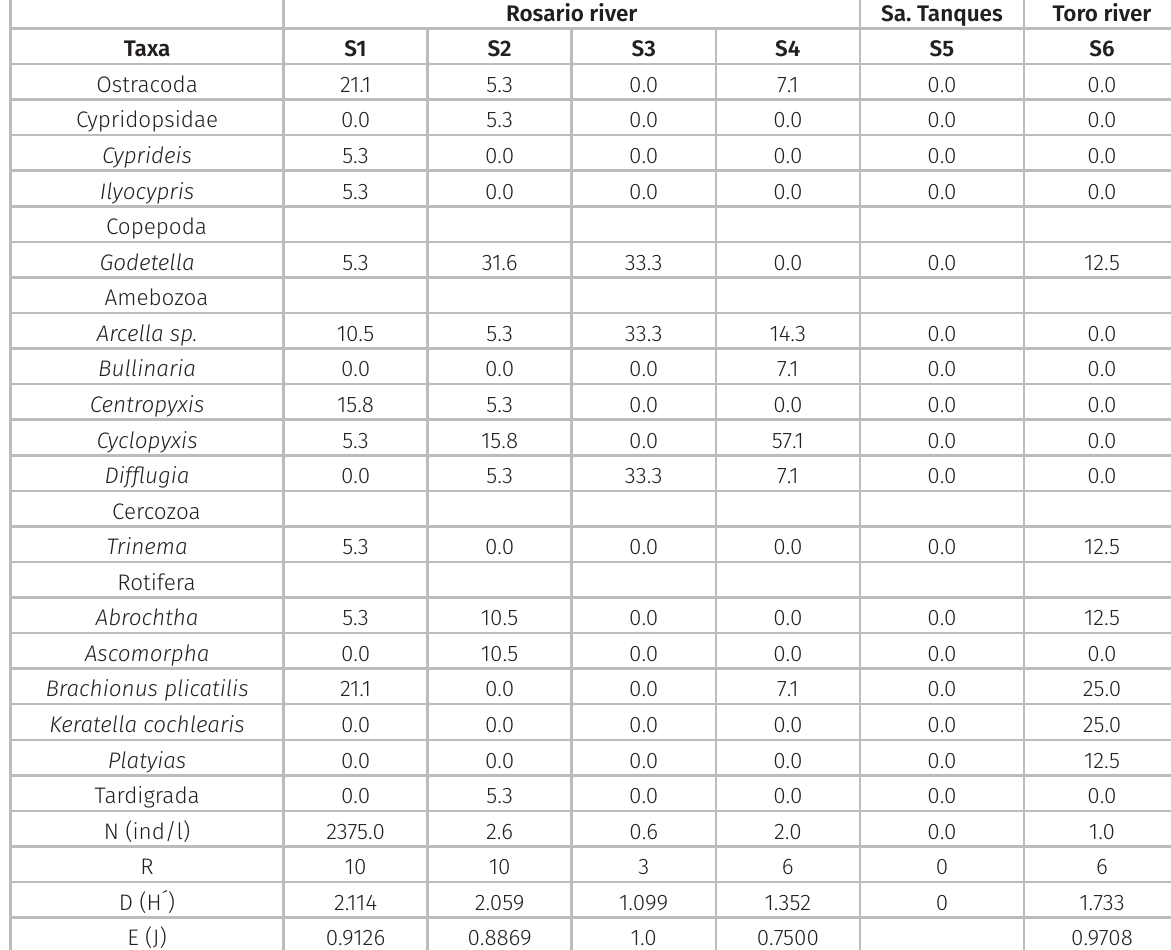
Table III. Microinvertebrates in Rosario basin (Salar de Olaroz, Jujuy, Argentina). Taxa specific abundances in percentage (%). S1 and S4 were placed at Rosario river; S5 at Sierra de Tanques stream; while S6 at Toro river. Abundance (N, ind /L), R (richness); D (diversity Shannon Wiener, H´); E (Equitability,